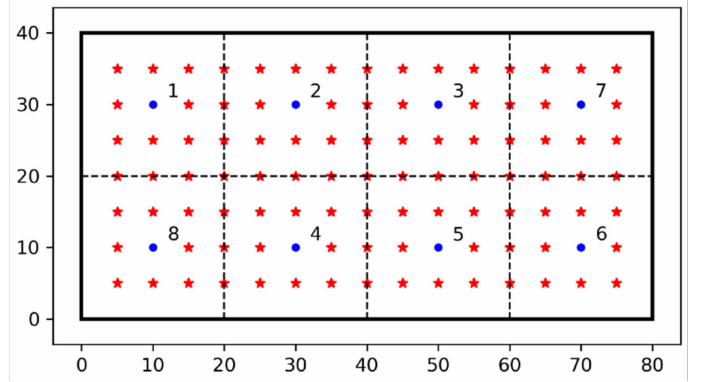
Figure 12. Locations of stores of the incumbent eight firms and ( (cid:70) ) possible locations for a new